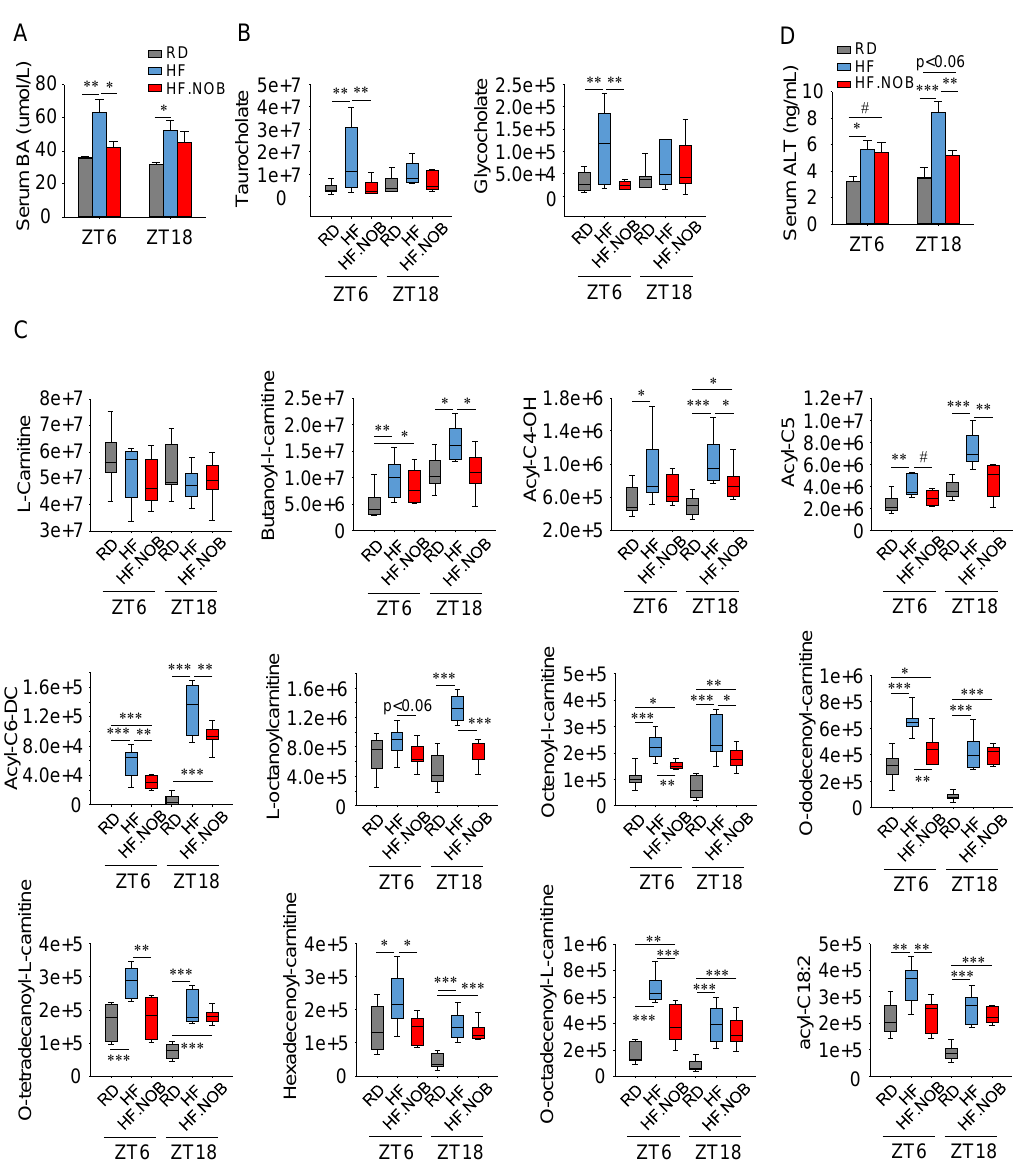
Figure 2. Nobiletin attenuates serum bile acid levels and other hepatic damage markers. ( A ) Serum total bile acid levels were measured by colorimetric assays ( n = 6–8). ( B ) Serum